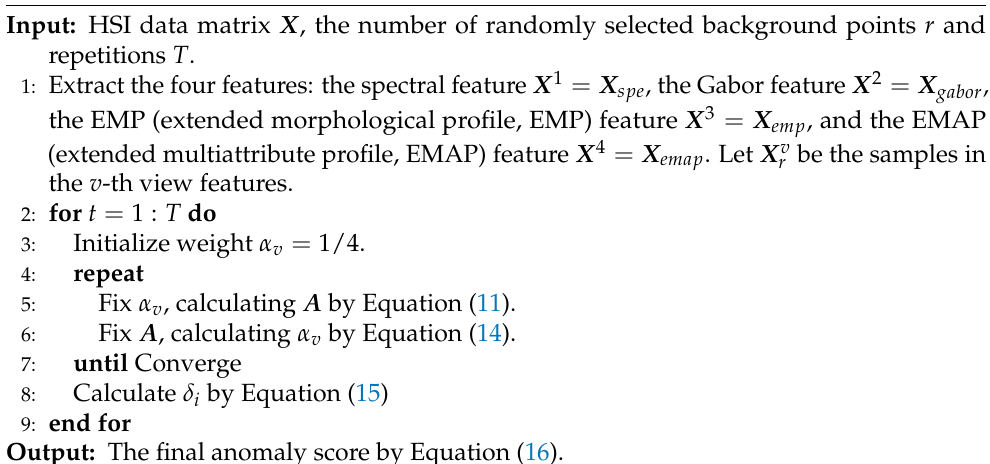
Algorithm 1 The algorithm of